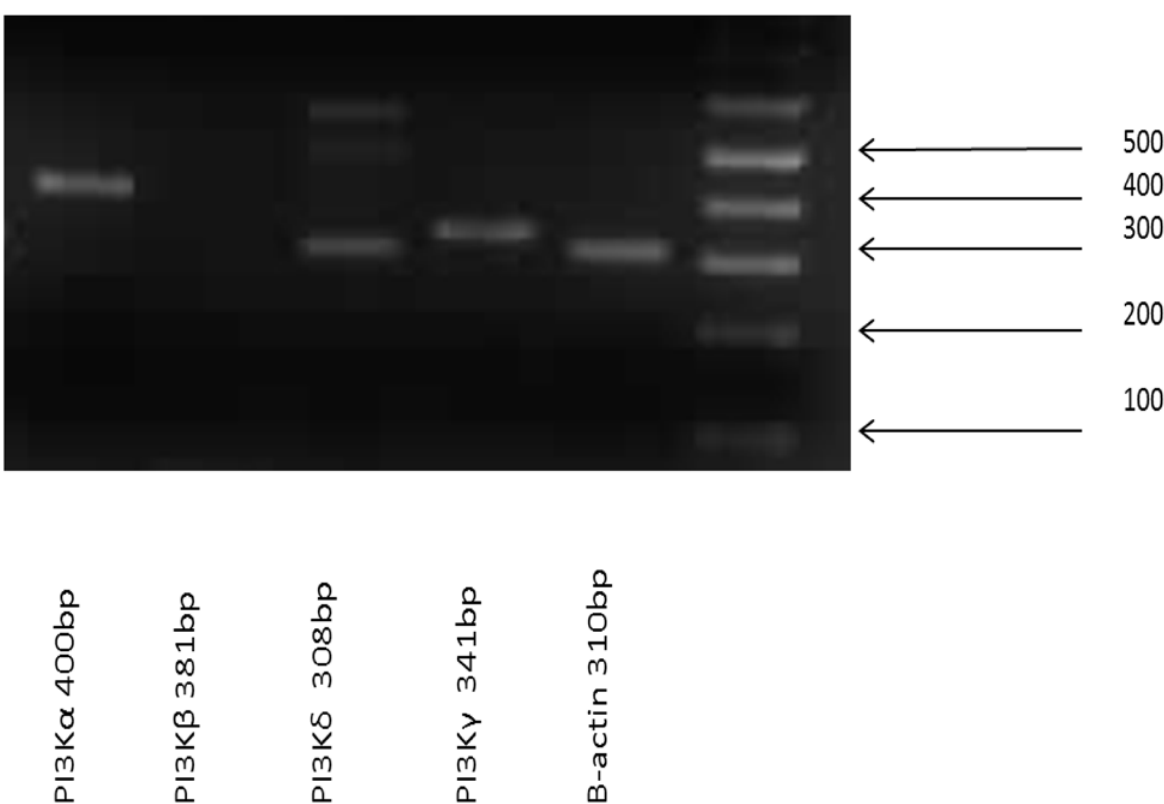
Fig 2. Neutrophils express the class I PI3K catalytic subunits α , δ and γ . RNA was isolated from unstimulated neutrophils. RT-PCR was carried out using primers for each of the four class I PI3-kinase catalytic isoforms and β -actin as a control. n = 1 representative of three experiments. The identity of each of the bands was confirmed by excising the band and sequencing the DNA